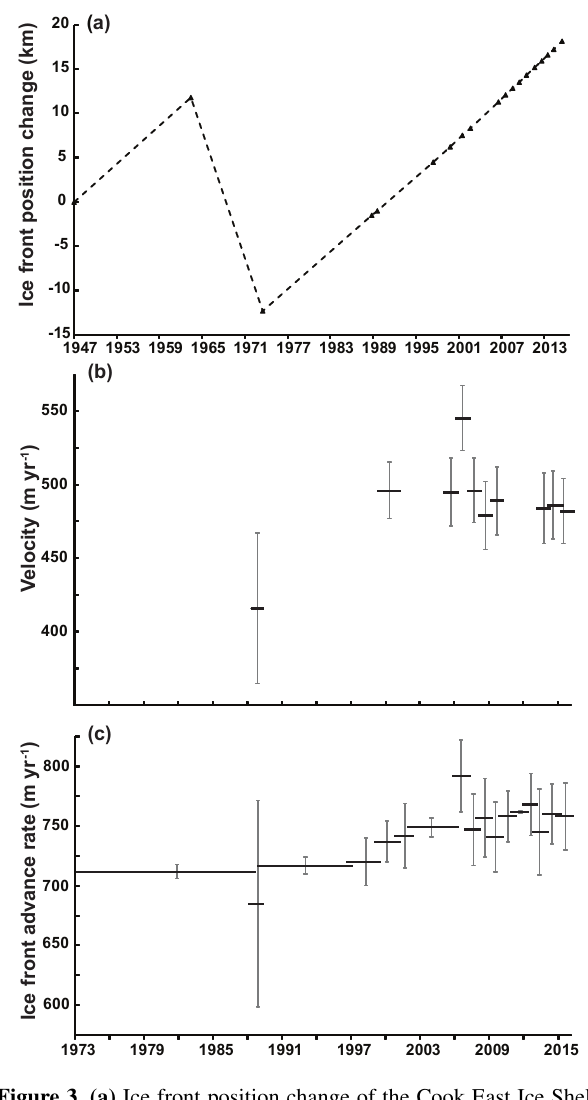
Figure 3. (a) Ice front position change of the Cook East Ice Shelf during 1947–2016 from the grey box delineated in Fig. 2. (b) Mean velocity extracted at the grounding line of Cook East during 1989– 2016. (c) Cook East ice front advance rate during 1973–2016. Note the increase in both velocity (b) and ice front advance rate (c) in the 1990s and between 2006 and 2007. Grey bars represent the errors in both (b) and (c)